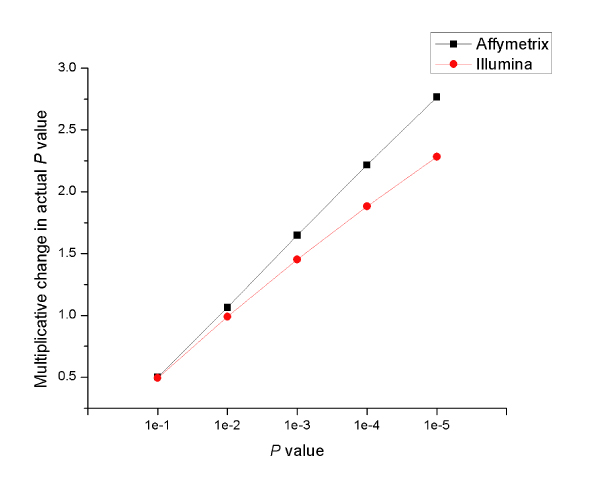
Multiplicative changes in p-values due to population structure.